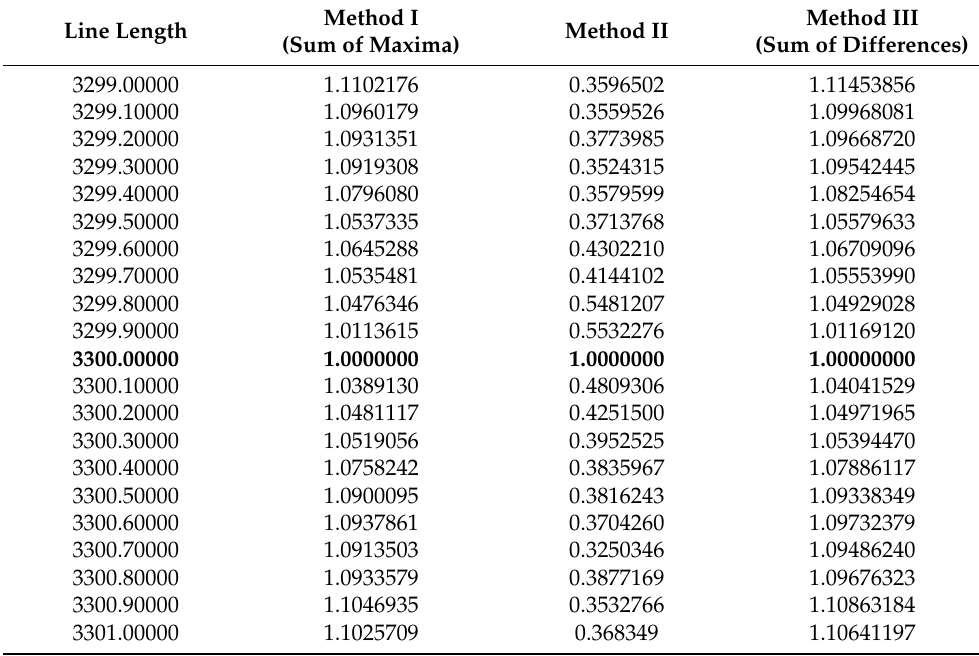
Table 13. Image line length estimation results for the accuracy ∆ = 0.1.